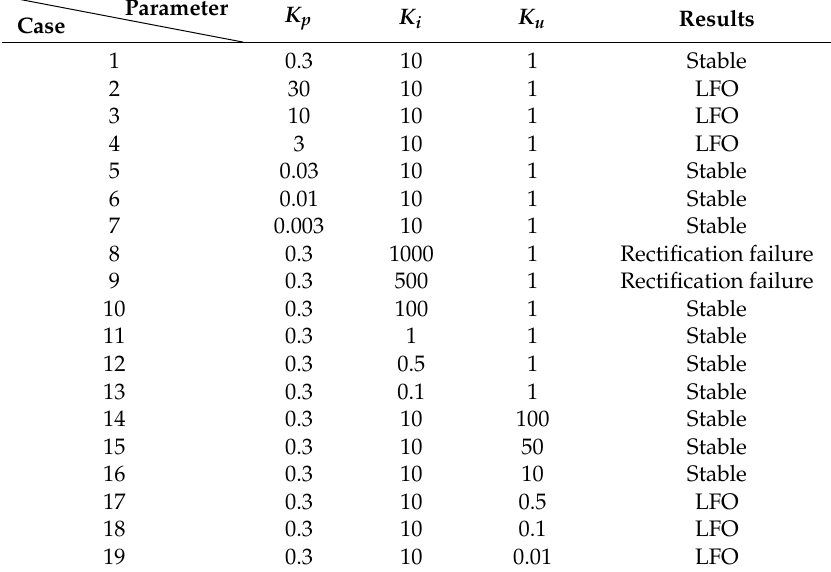
Table 6. Parameter effect based on